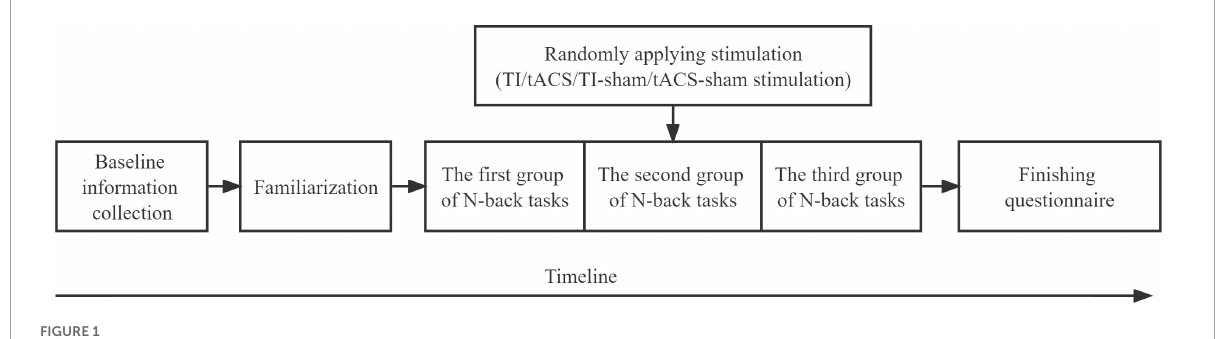
FIGURE1 Study procedure. TI, temporal interference; tACS, transcranial alternating current